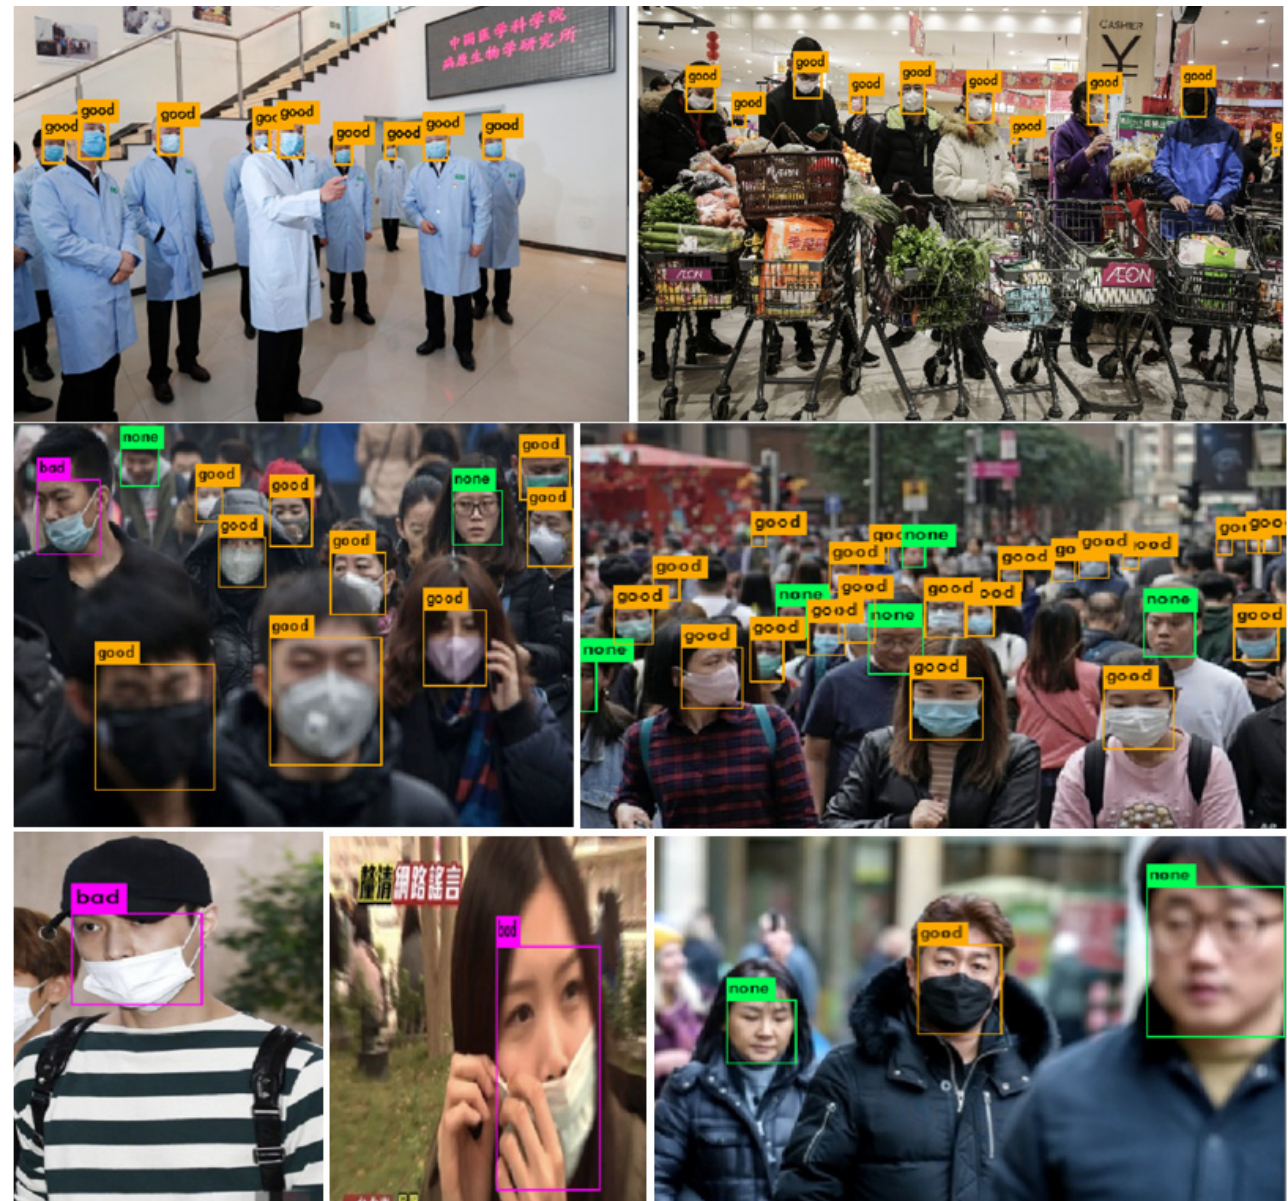
Figure 7. Recognition results using Yolo V4 CSP SPP. Source of the human faces: The FMD and MMD datasets.